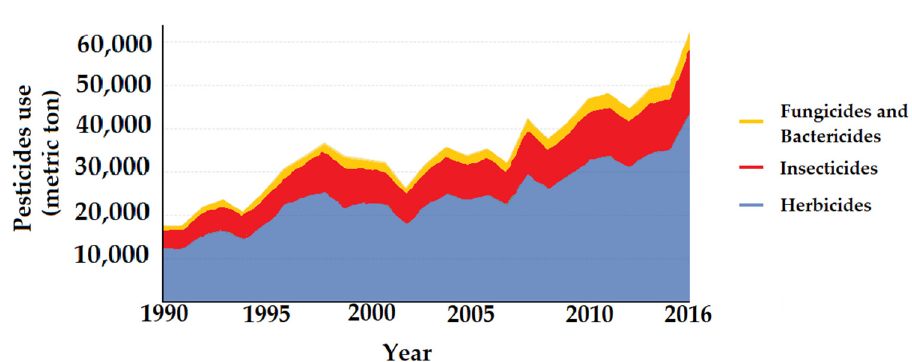
Figure 2. Pesticides use from 1990 to 2016 (data from [4]).